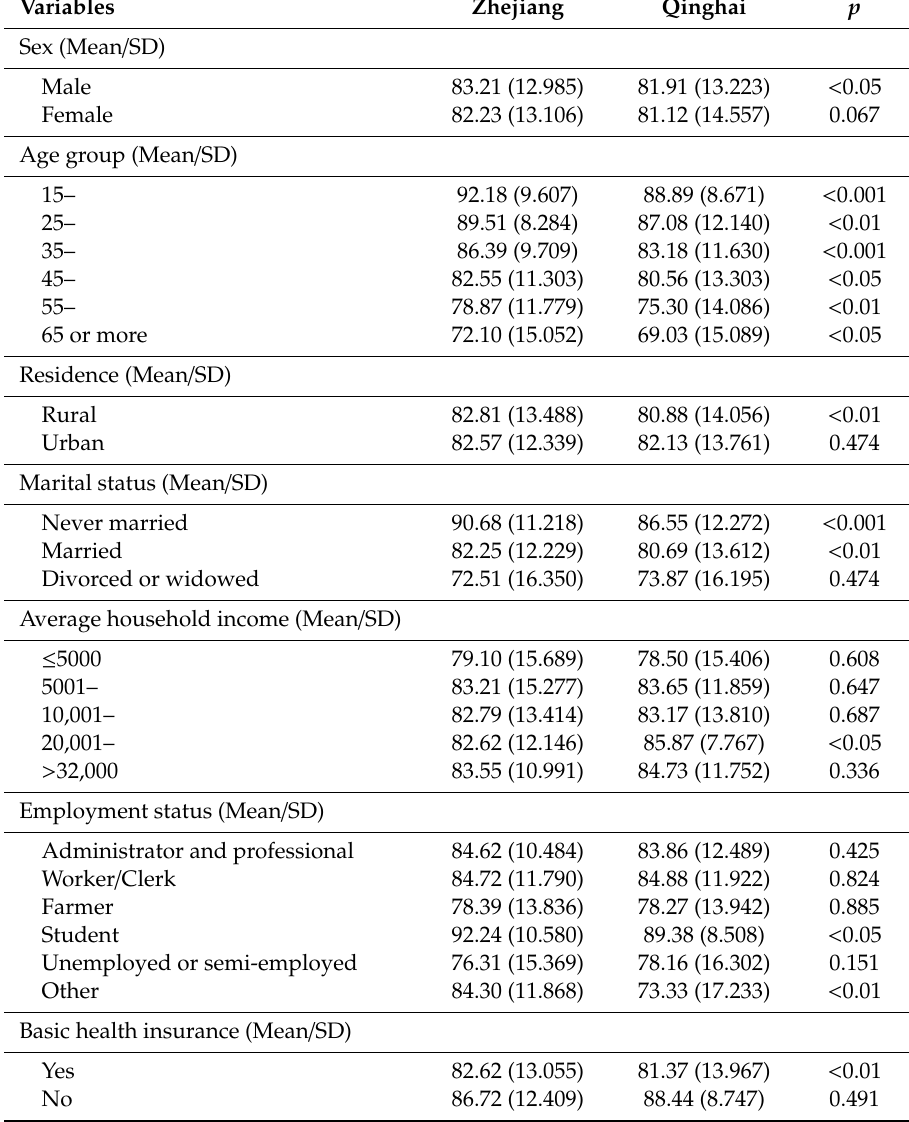
Table 4. Health-related quality of life by sociodemographic